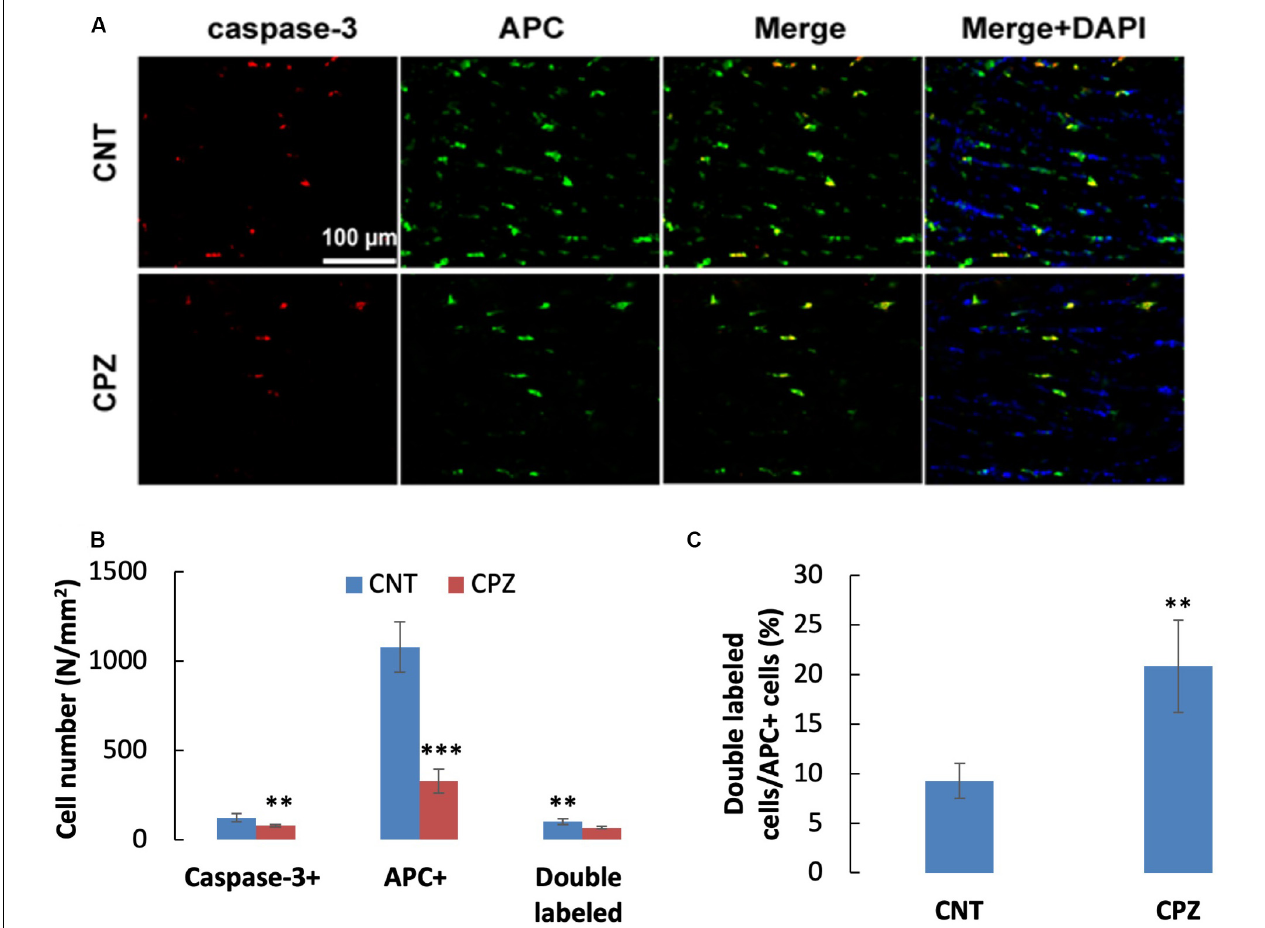
FIGURE 7 | (A) Representative photographs showing cells labeled by the antibody to caspase-3, antibody to APC, and double labeled cells by the two antibodies. (B,C) Bar charts showing the statistical analysis results of the immunofluorescent staining. Data are expressed as means ( SD (n ( 6/group). ** p < 0.01, *** p < 0.0001. The comparisons were made between CNT and CPZ groups by performing t -test or chi-square test (percentage of double labeled cells in APC + cells).